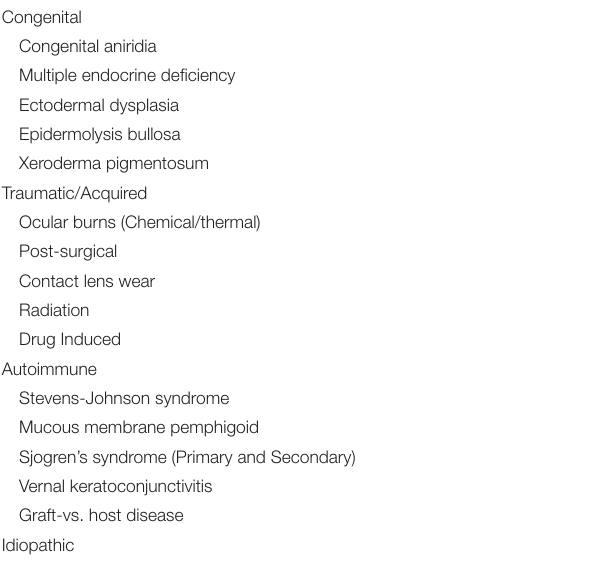
TABLE 1 | Causes of limbal stem cell